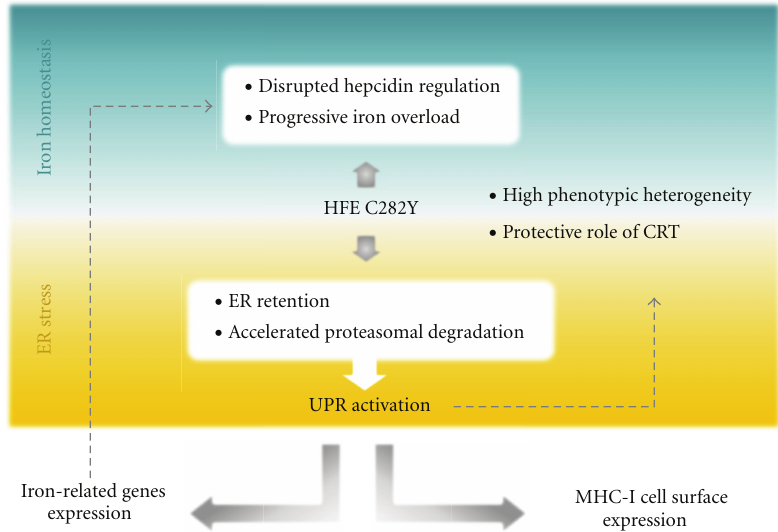
Figure 3: ER stressing iron homeostasis. Iron homeostasis (upper panel). Hepcidin is today thought to be the key regulator of iron homeostasis. Lower hepcidin levels have been seen associated with progression of iron overload in Hereditary Hemochromatosis (HH). HH is intrinsically related to the gene HFE and to a point mutation commonly known as C282Y replacing cysteine by tyrosine at position 282. A high proportion of HH patients are homozygous for the C282Y mutation. ER stress (lower panel). Studies by two separate groups showed in recent years that the C282Y mutation in HFE provoked the activation of the Unfolded Protein Response (UPR) leading the two groups to consider HH a conformational disorder. In addition, some clinical phenotypic heterogeneity reported in HH has been related to variation in levels of mRNA expression of the endoplasmic reticulum (ER)-chaperone calreticulin (CRT). UPR activation has also been shown by separate groups to a ff ect hepcidin gene expression. The intriguing e ff ect of the UPR on cell surface expression of MHC class I may also contribute to the phenotypic heterogeneity of HH through its putative peripheral e ff ect on numbers of circulating CD8 + T